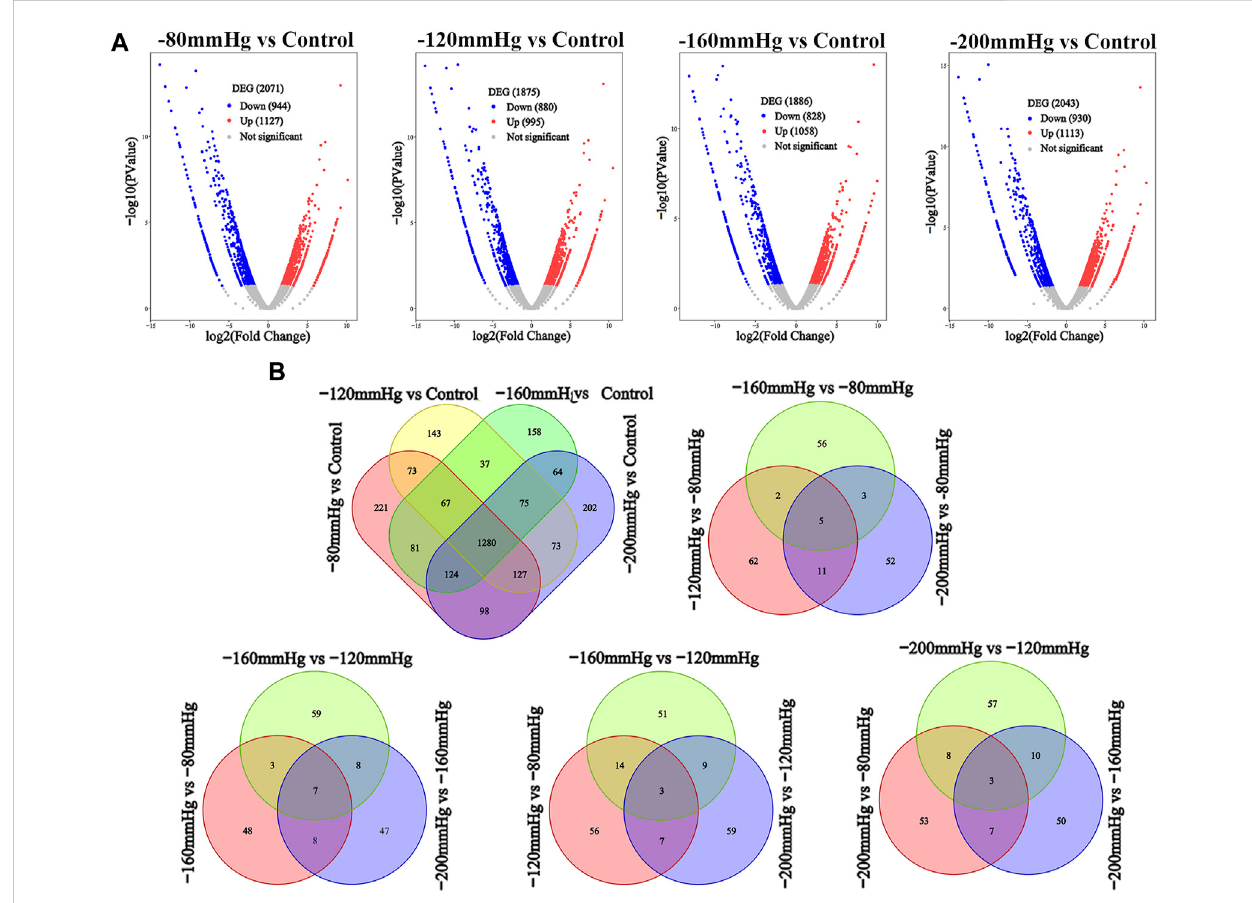
FIGURE 8 DEGs analysis among four NPs vs. control. (A) Volcano analysis of DEGs in − 80 mmHg vs. control, − 120 mmHg vs. control, − 160 mmHg vs. control and − 200 mmHg vs. control, respectively. (B) Venn diagram of the DEGs in BMSCs with NP treatment.